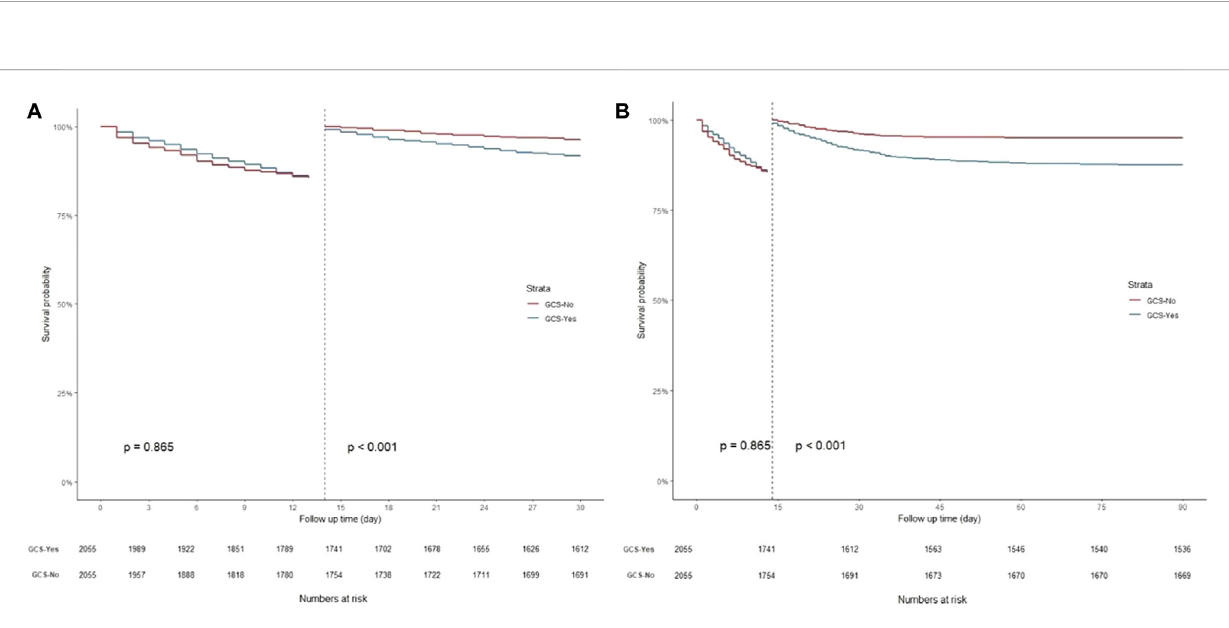
FIGURE 4 Landmark analysis discriminating between survival probability before and after 14 day of follow-up. (A) Landmark analysis during 30-day follow-up; (B) Landmark analysis during 90-day follow-up.